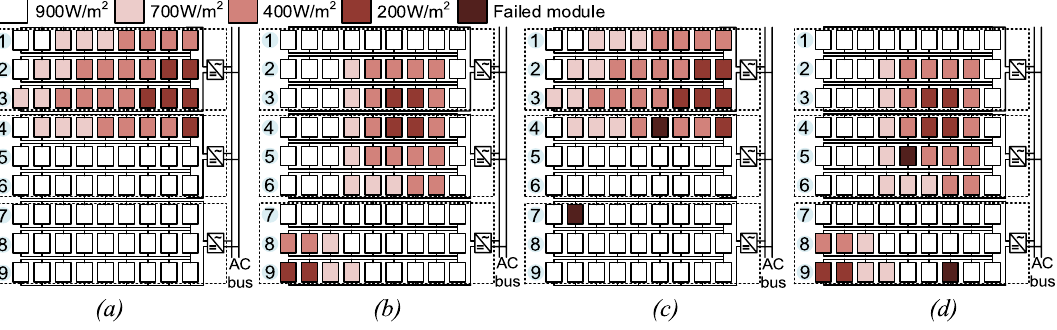
Fig. 7 Four mismatch scenarios ( a ) Scenario 1 (long and wide shading); ( b ) Scenario 2 (double parts shading) ( c ) Scenario 3 (long and wide shading with random modules failure); and ( d ) Scenario 4 (double parts shading with random failure